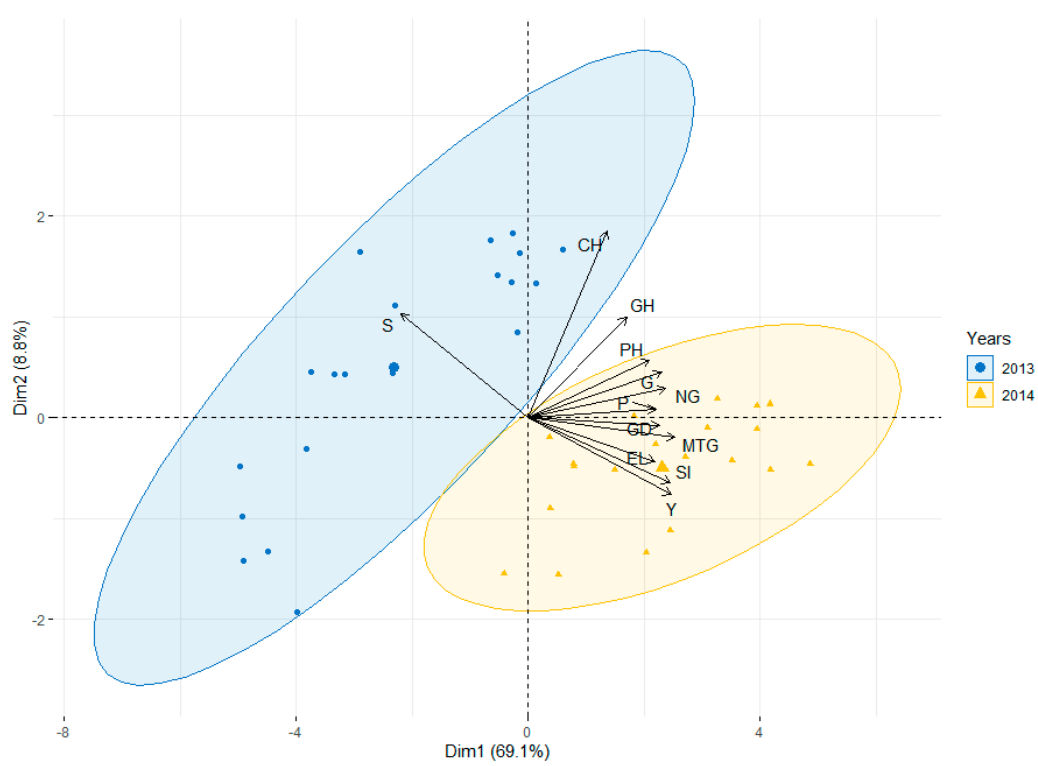
Figure 4. PCA biplot showing the interaction between concentrations of acetylsalicylic acid (ASA3, ASA5) used in two terms (T1/T2, T3/T4) and selected traits in spring wheat analyzed in both years. PH-plant height; EL-ear length; CH-chlorophyll; NG-number of grains per ear; MTG-mass of a thousand grains; Y-yield; P-proteins in grain; G-gluten in grain; S-starch in grain; SI-sedimentation index; GH-grain hardness index; GD-grain density.